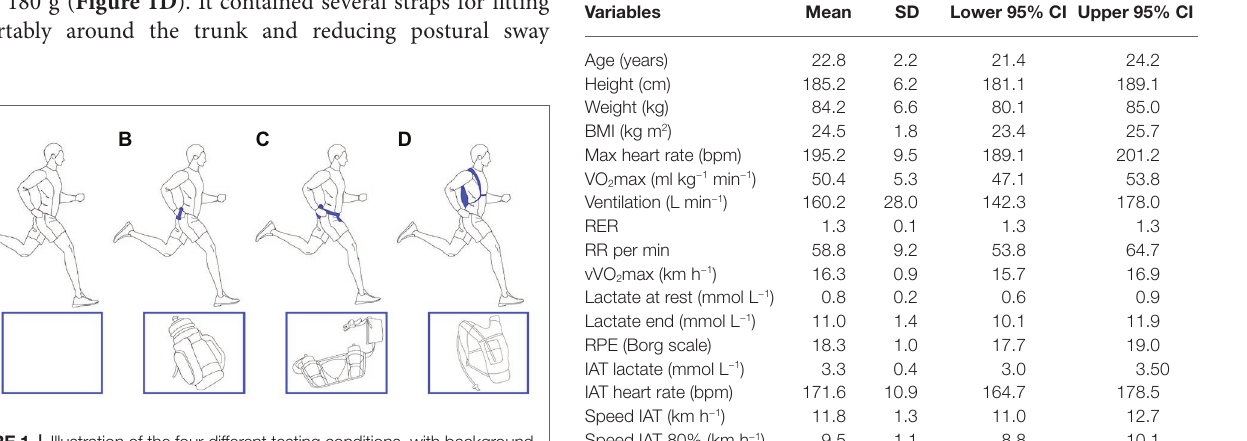
FIGURE 1 | Illustration of the four different testing conditions, with background showing runner with the system and the front box the system only. From left to right, the figure shows runner (A) in control condition with no water carriage, (B) with handheld bottle, (C) with waist belt, and (D) with backpack.